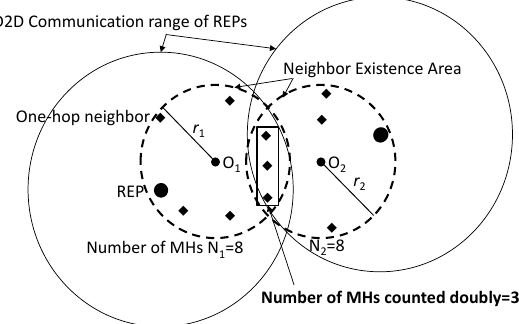
Figure 11. Example of mobile hosts that are included in the NEA of different P-REPs.